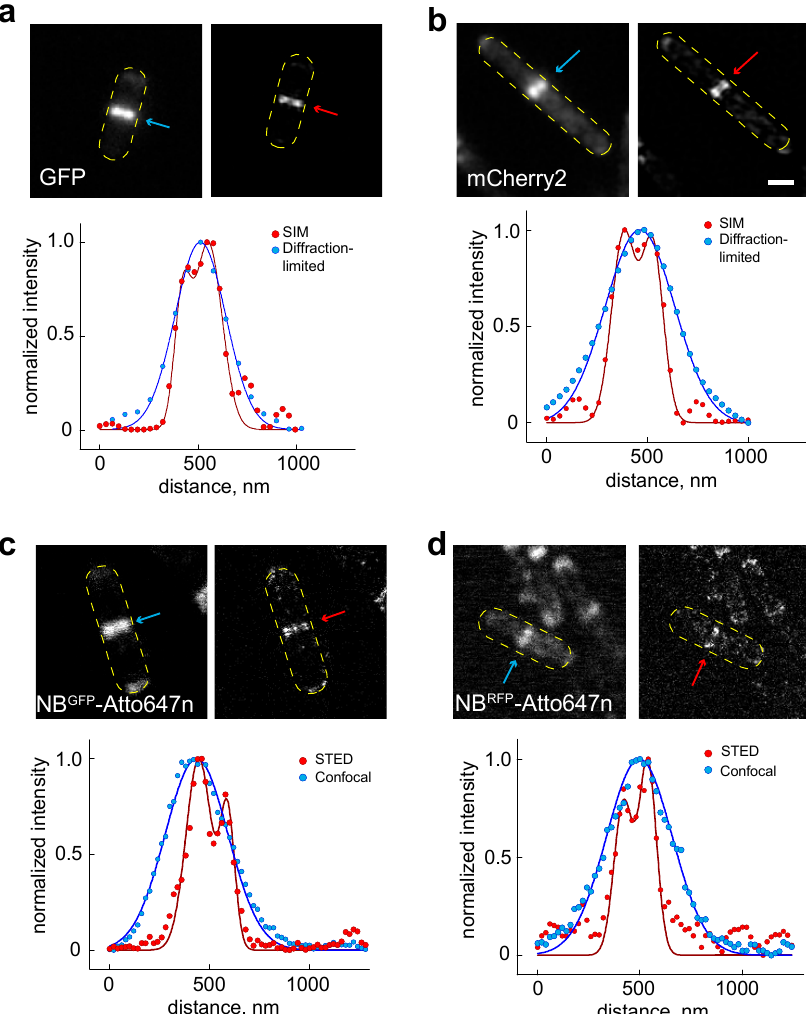
Figure 2. Visualization of the cell division protein DivIVA using SIM and STED microscopy. (a, b) Fluorescent signal from cells expressing either GFP or mCherry2 fused to DivIVA was imaged using diffraction-limited (left panel) and SIM (right panel) microscopies. Intensity profile of the signal along the longitudinal axis of the cell is shown in the lower panel. (c, d) Fluorescent signal from cells incubated with the Atto647n conjugated to either GFP nanobody (NB GFP -Atto647n) or RFP nanobody (NB RFP -Atto647n) was imaged using a conventional confocal (left panel) and STED (right panel) microscopy. The intensity profile of the signal along the longitudinal axis of the cell is shown in the lower panel. Scale bar 1 μ m.